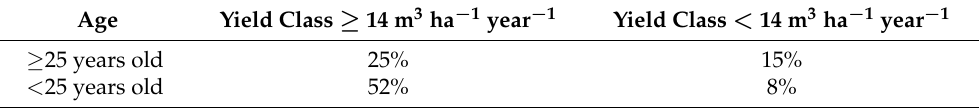
Table 1. Percentage breakdown of the Slieve Blooms mountains spruce forests by age and yield